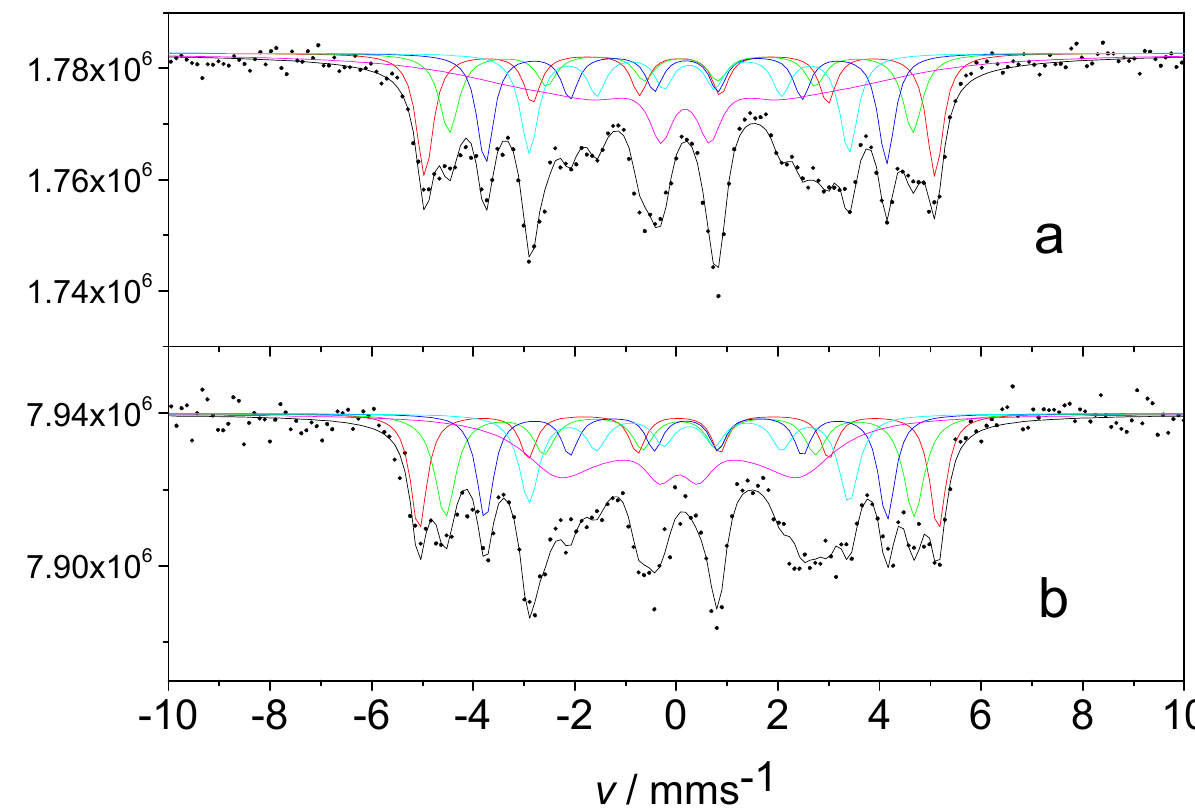
Figure 4. Room temperature transmission 57 Fe Mössbauer spectra of FINEMET samples CK021 ( a ) and CK022 ( b ) after their second irradiation by 160 MeV 132 Xe ions at a fluence of 10 13 ion cm − 2 when they were irradiated from both sides.